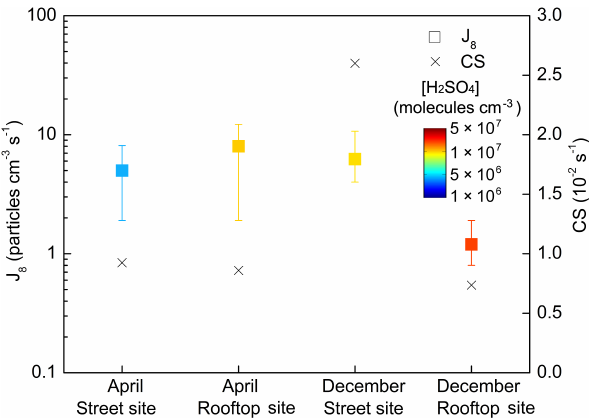
Figure 8. Mean and range of FR (box symbol), condensation sinks (cross symbol), and estimated sulfuric acid concentrations (mean and standard deviation) as shown by the color bar on NPF days at two sites in April 2012 and December 2011 (the sulfuric acid at the street site was calculated by assuming the mixing ratio of SO 2 therein to be the same as that on the rooftop, and the uncertainty on the estimation is analyzed in the